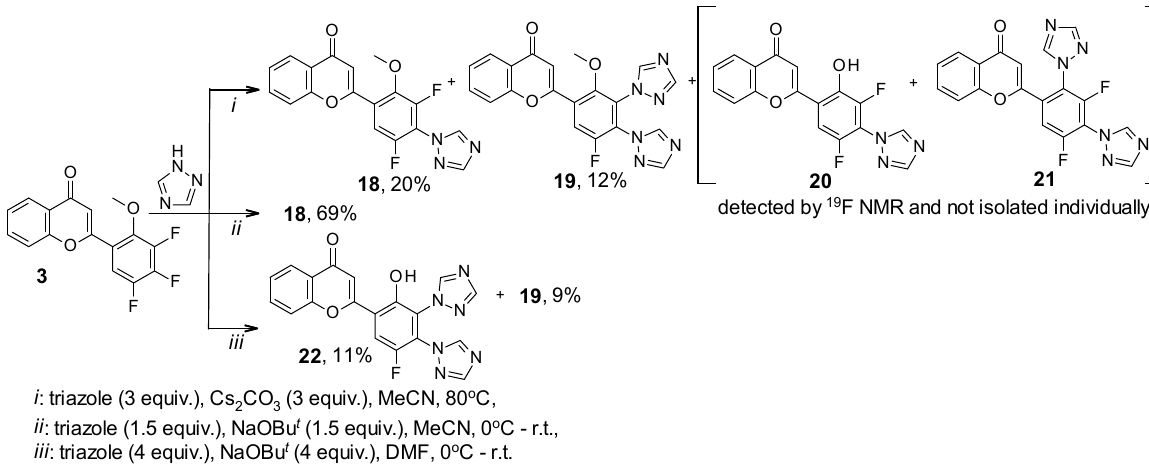
Figure 4. Molecular structure and selected torsions ( a ), and unit cell ( b ) of compound 15 with atoms represented as thermal ellipsoids of thermal vibrations with a 50% probability.